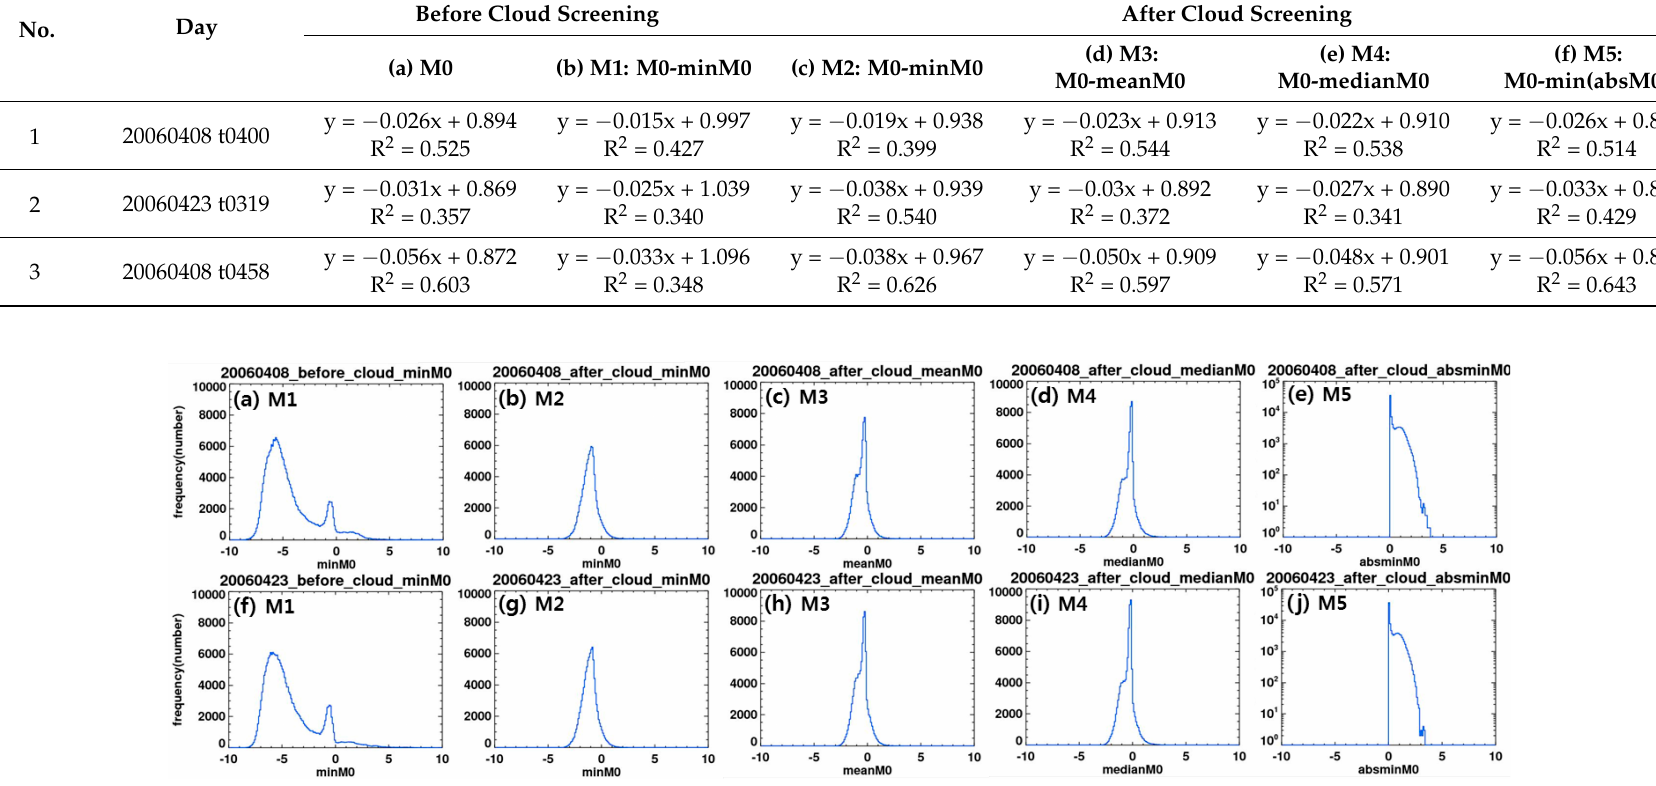
Table 4. Six empirical SAI models (M0 to M5) are categorized with background AI marked in bold. Slopes and correlation coefficients of six empirical models with respect to SSA are presented. ‘20060408’ indicates the selected day and ‘t0400’ indicates the OMI passing time (in this case UTC 04:00). The empirical model (c) M0-minM0 showed the highest correlation coefficient and a linear relationship (see also Figures 4 and 5).